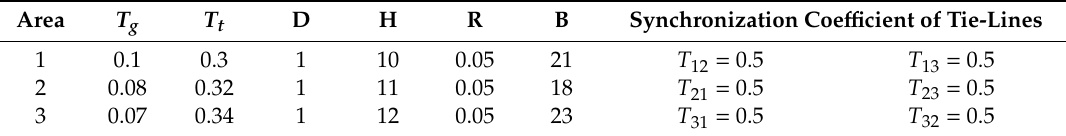
Figure 12. Communication transmission delay between client substations and the server substation. Table 2. Model parameters of the three-area system.